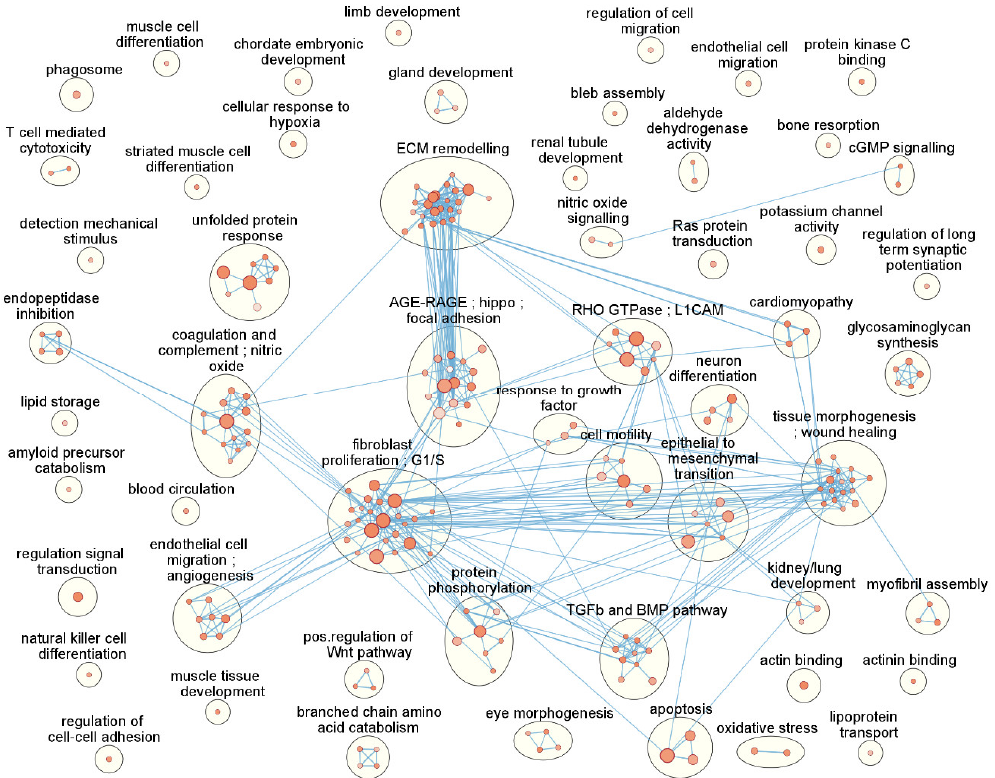
Figure 3. Clustered enrichment results. Clustered enrichment terms based on over-representation analysis (ORA) of a gene list of significantly differentially expressed genes (FDR < 0.05) in normal human trabecular meshwork cells after TGF-β1 treatment. Each node corresponds to an enrichment term. The node intensity represents the nominal p -value in a range 0.00 (darkest) to 0.01 (lightest) while the node size corresponds to the number of genes associated with a particular enrichment term. Blue lines represent gene list overlap between enrichment terms above a threshold of 0.25. Clustered enrichment terms have been encircled and